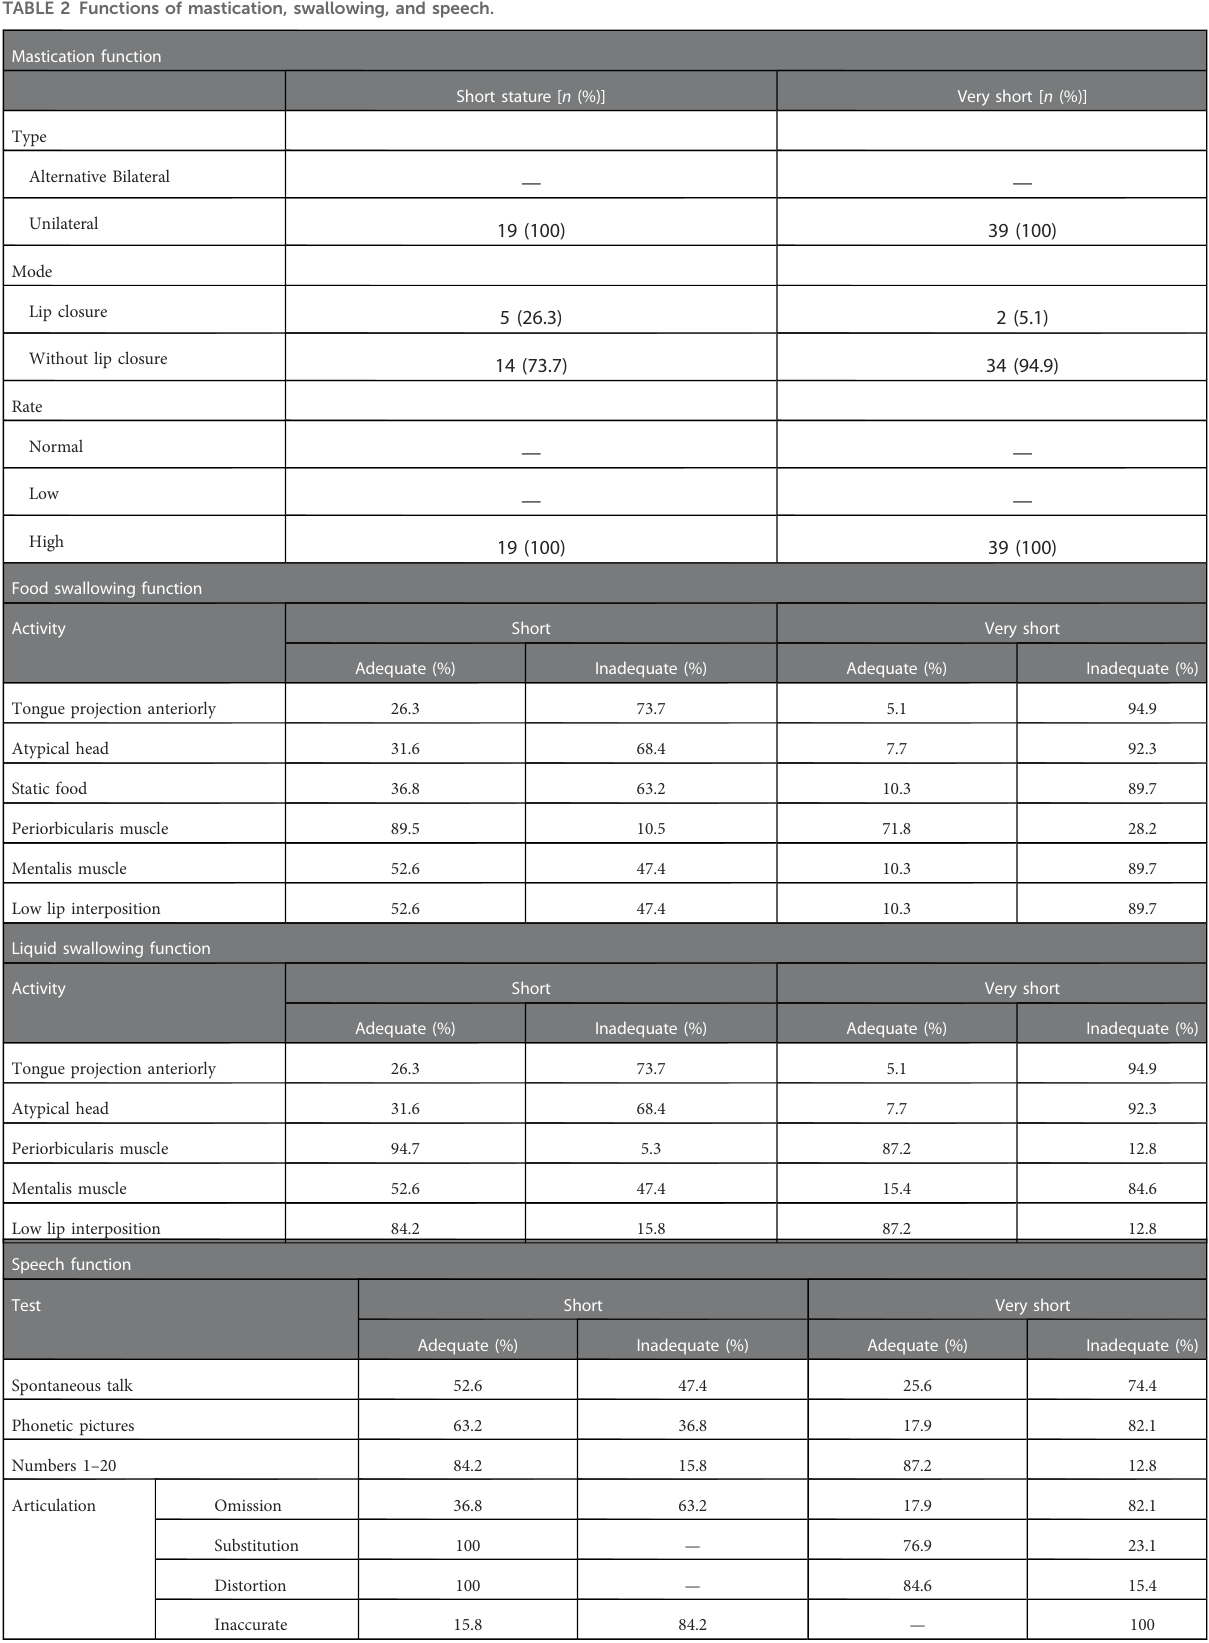
TABLE 2 Functions of mastication, swallowing, and